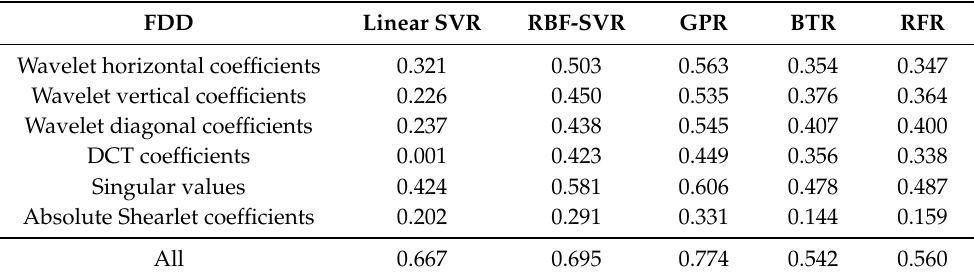
Table 8. Comparison of different FDD feature vectors extracted from different domains and differ- ent regression modules on ESPL v2.0 [48] database. Median SROCC values were measured over 1000 random train–test